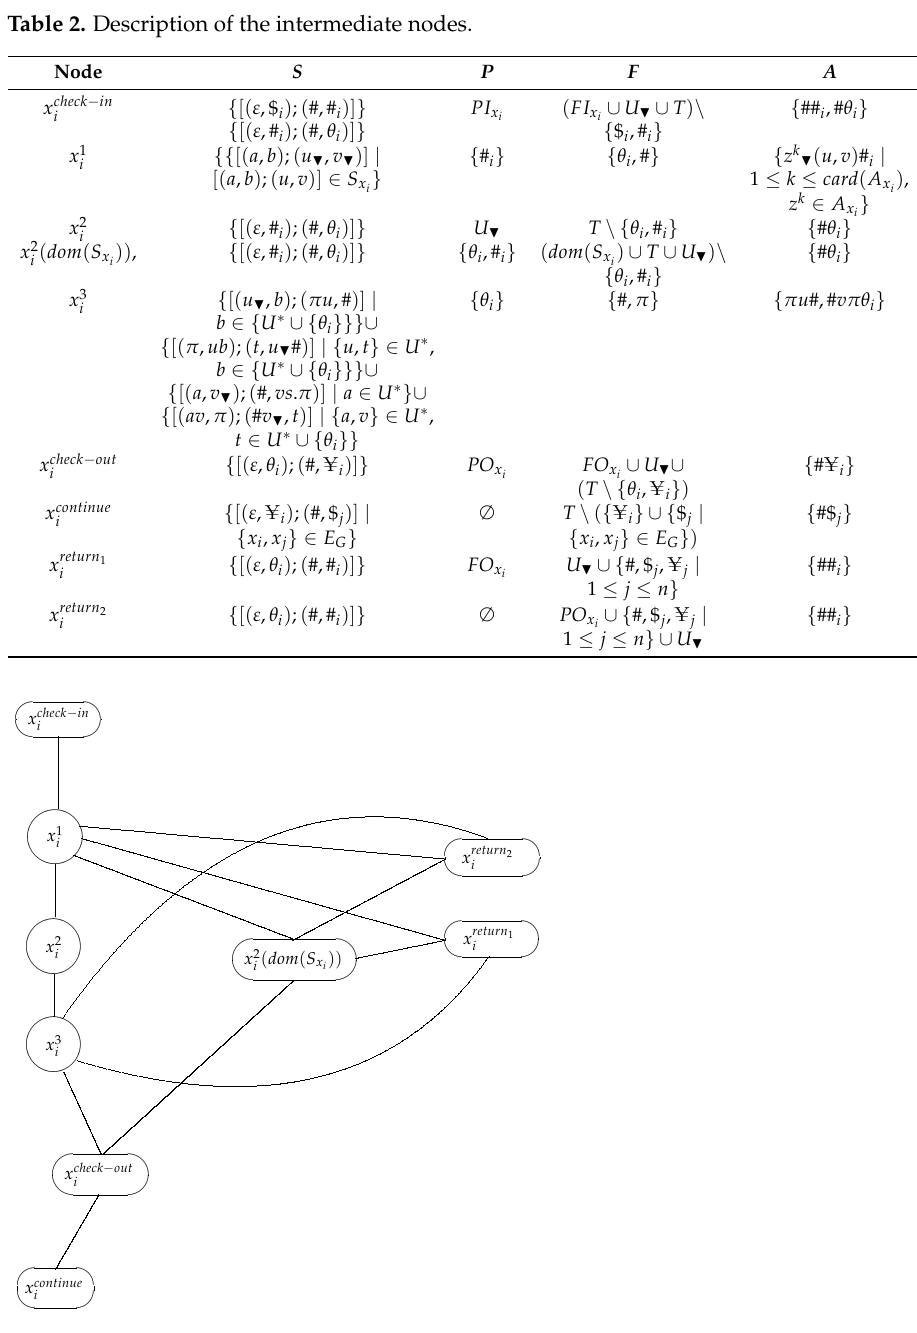
Figure 1. A graphical representation of the network. Table 3. Description of the returning nodes.